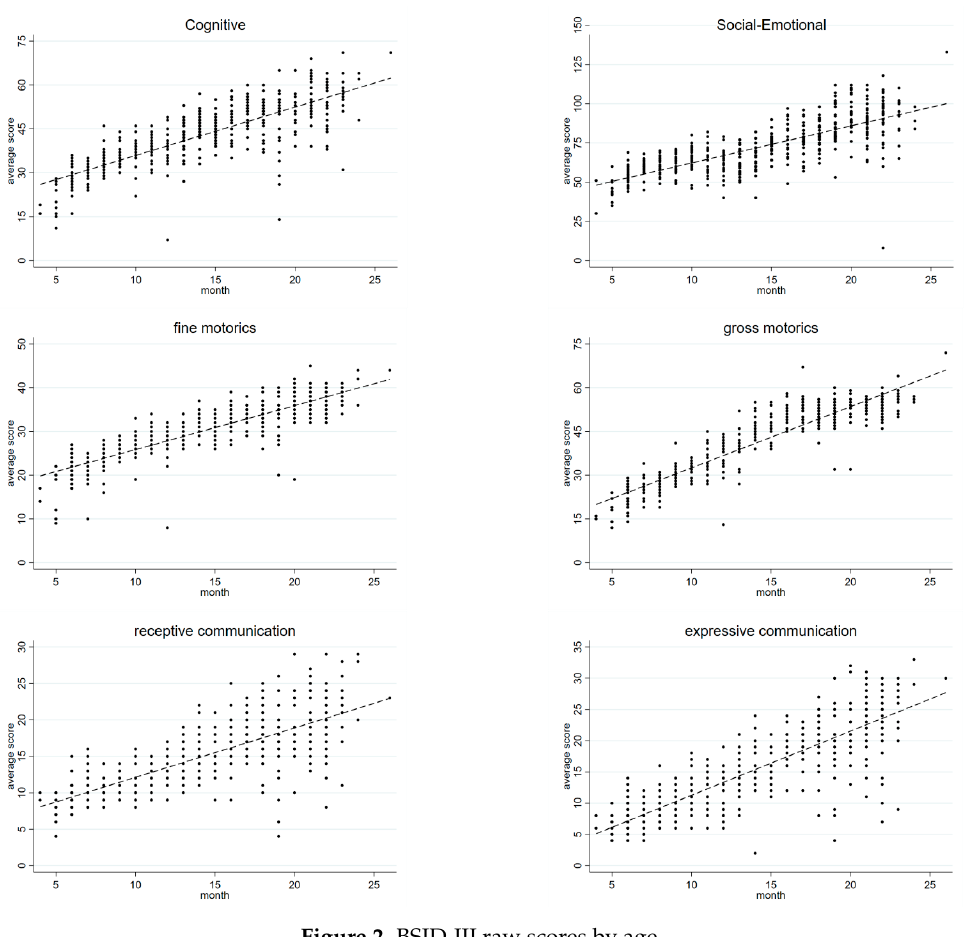
Figure 2. BSID-III raw scores by age.